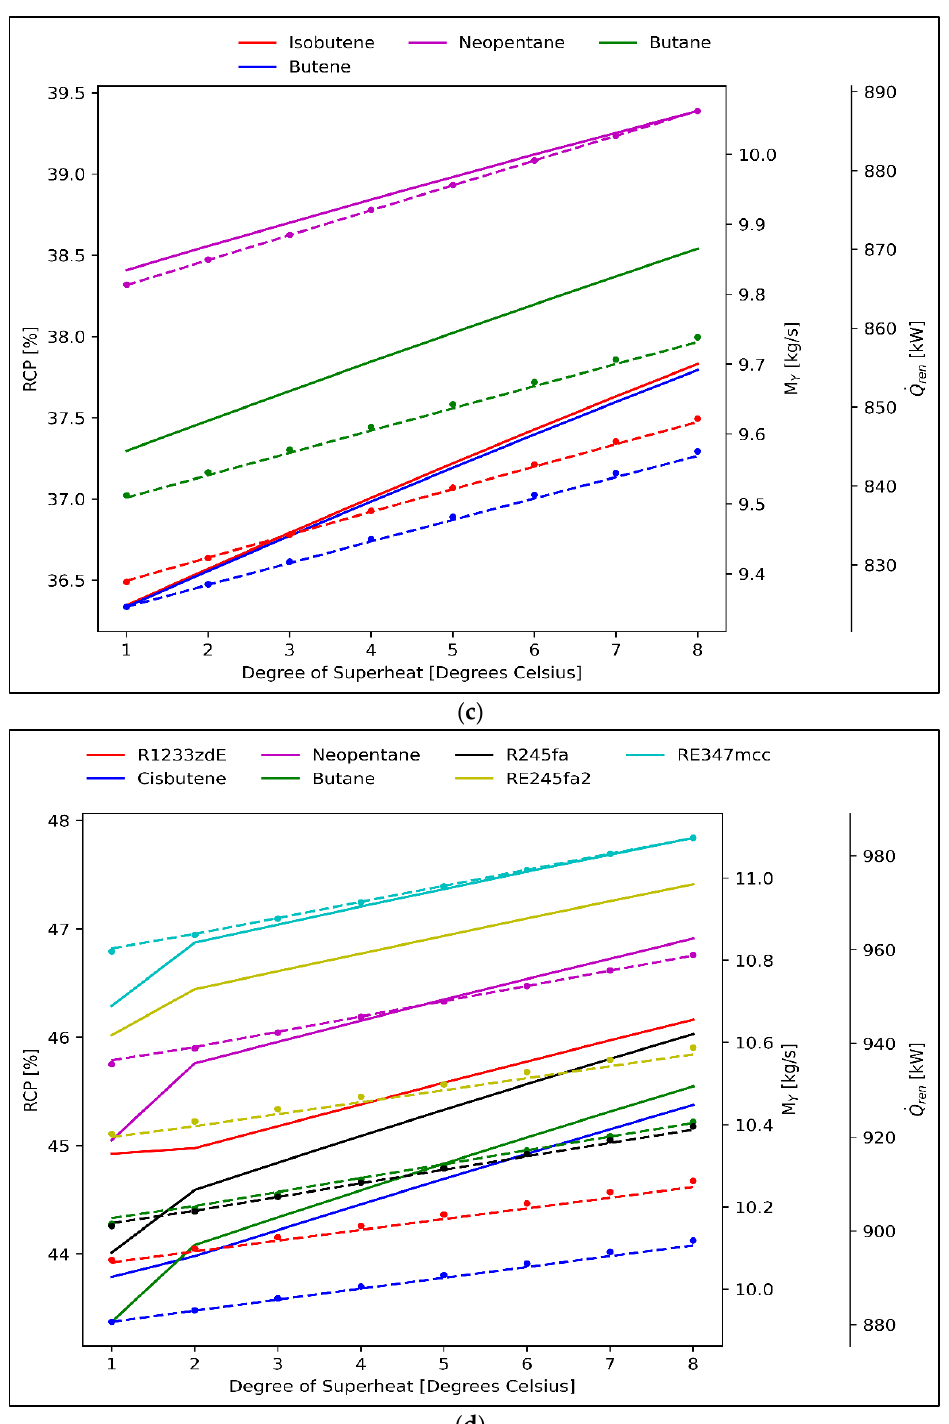
Figure 6. Degree of evaporator superheat vs. reduction in power consumption and renewable en- ergy input ( a ) at 90 °C; ( b ) at 100 °C; ( c ) at 110 °C; and ( d ) at 120 °C. Solid Lines: RCP , Dots: 𝑄̇ 𝑟𝑒𝑛 , input ( a ) at 90 ◦ C; ( b ) at 100 ◦ C; ( c ) at 110 ◦ C; and ( d ) at 120 ◦ C. Solid Lines: RCP , Dots: Dashed Lines: M Y . Lines: M Y